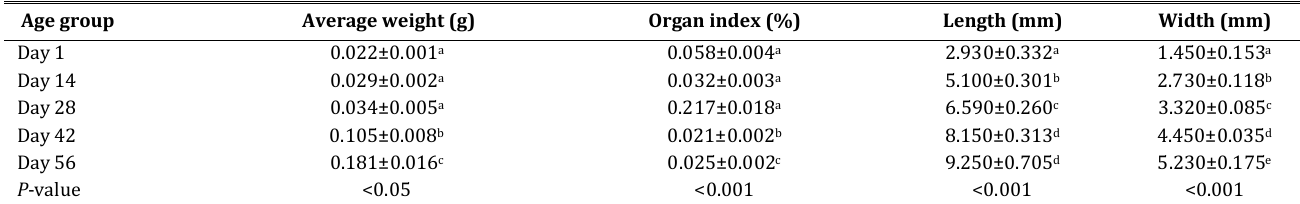
Table 1: Gross-morphometric observations of cecal tonsil of Sonali chicken 1 Age